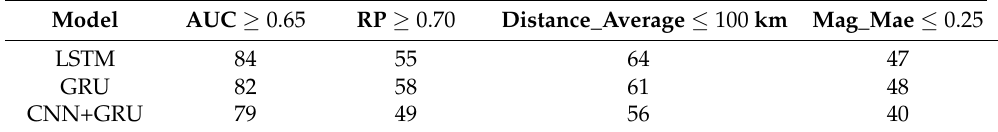
Table 2. The results of time series